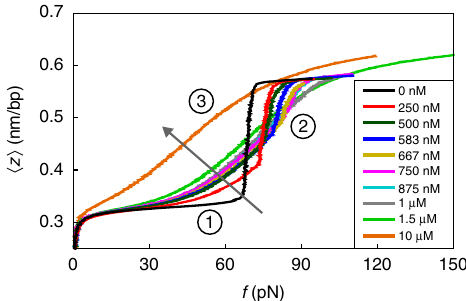
Fig. 1 The extension z per base pair as a function of the stretching force f for single dsDNA molecules in aqueous solution containing a wide range of concentrations of the intercalator YO-PRO. The arrow indicates the direction of increasing concentration. The key features described in the main text are indicated by 1, 2 and